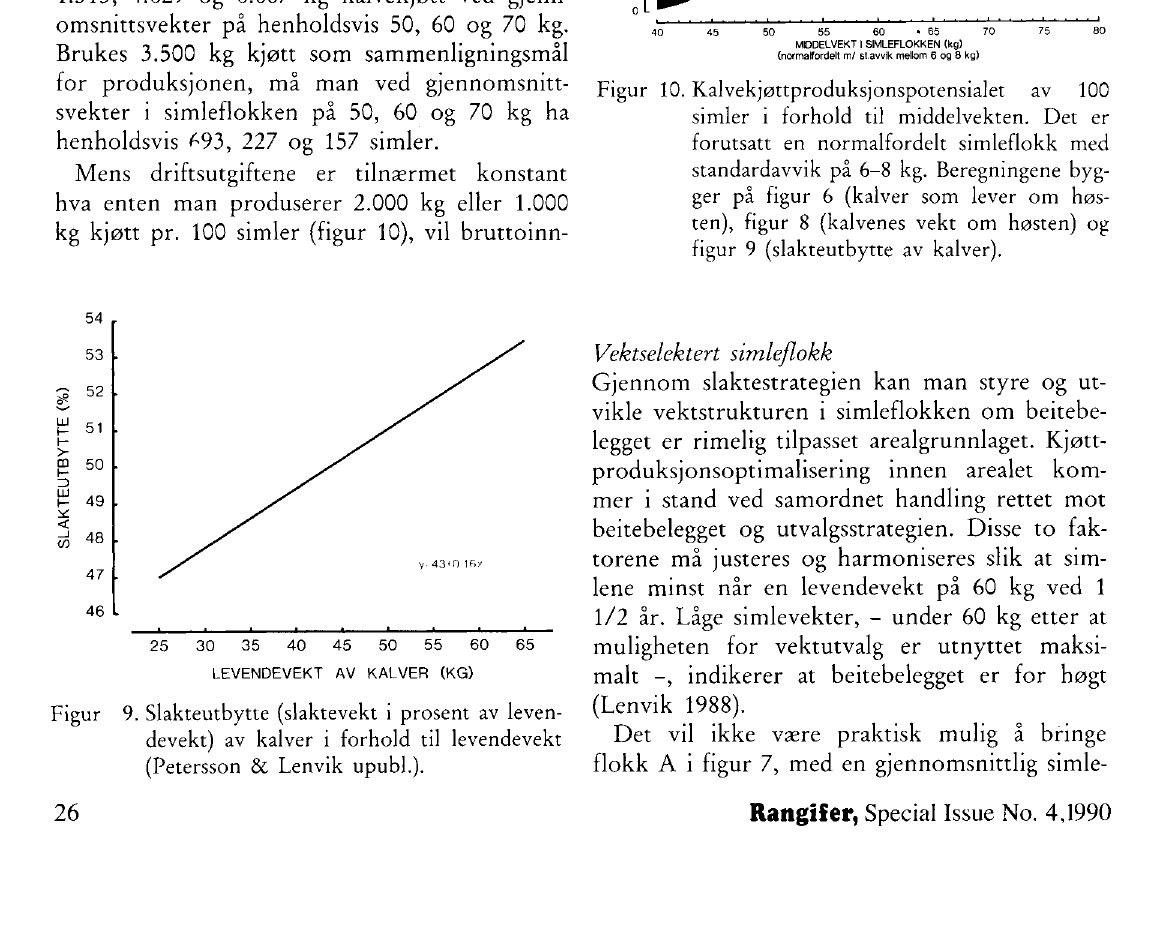
Figur 8. Vekt av kalver i Riast/Hylling-flokken i november 1984 i forhold til mødrenes vekt samme vår (mars 1984). Antall registrerin-. ger innen vektklasse er angitt (Lenvik et al. 1988).